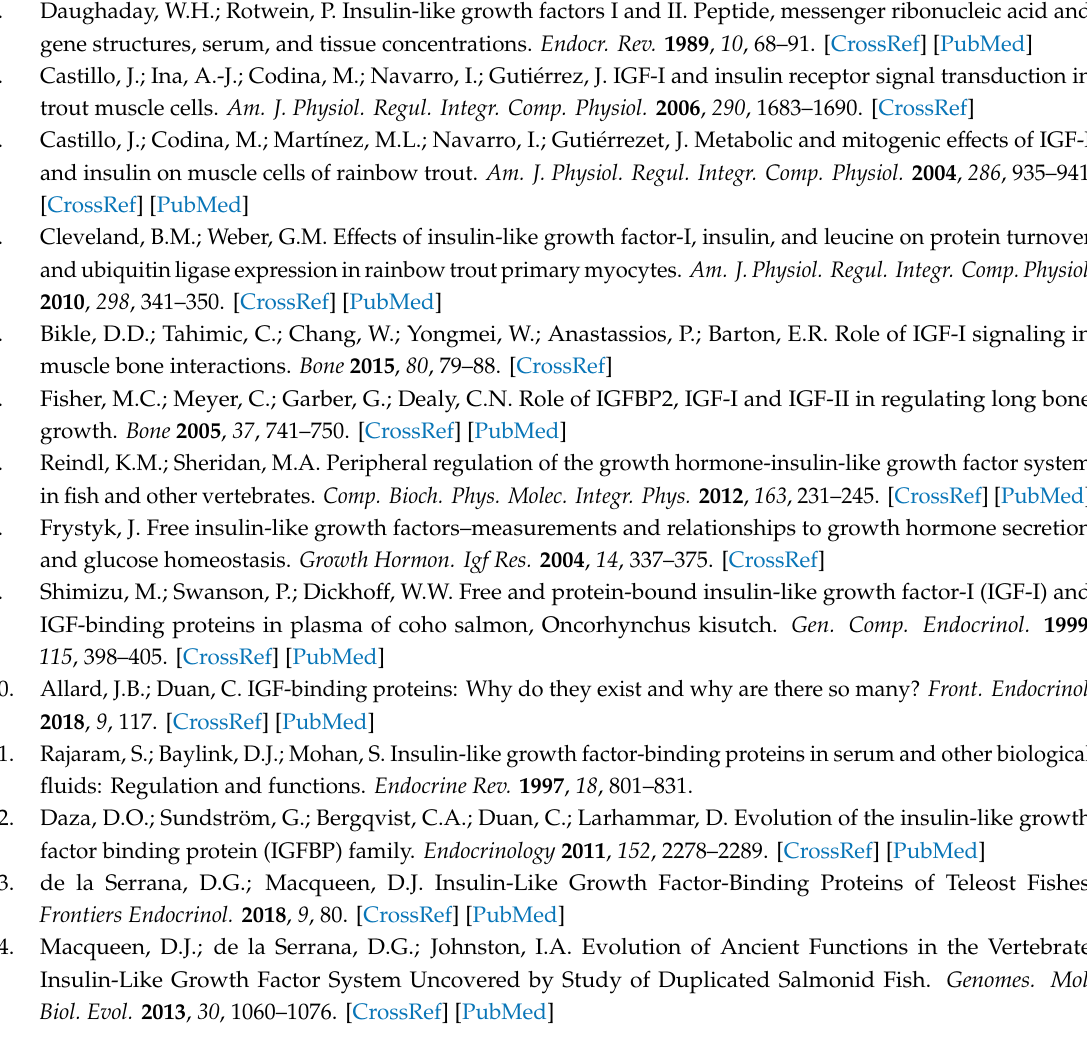
Table S1: Primers used for PCR and RT-PCR; Table S2: Fold changes in serum variables and gene expression in liver; Table S3: Fold changes in gene expression in white